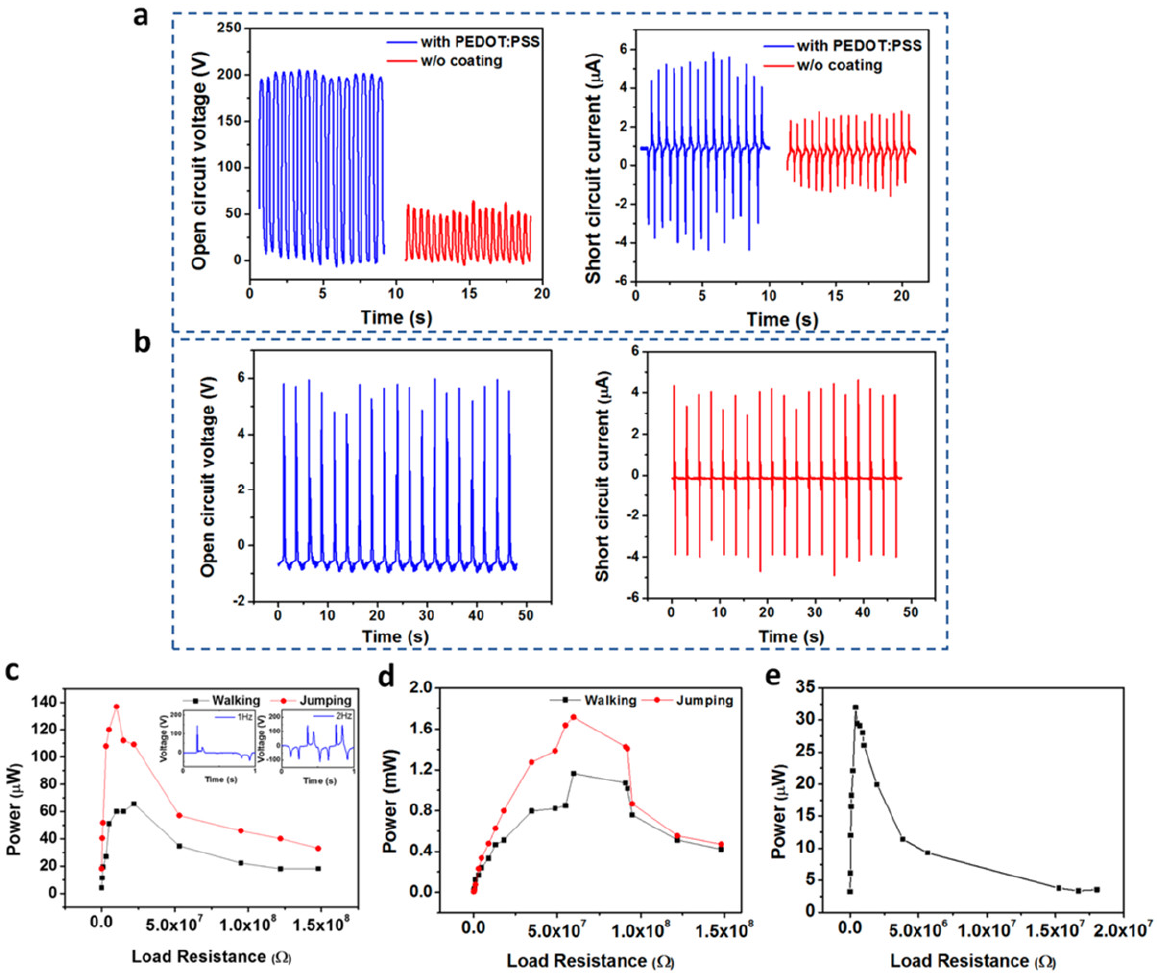
Figure 9. Output electrical performance of the TENG and piezoelectric device integrated in a S 2 -sock designed by Zhu et al. [105]. ( a ) Results of open-circuit voltage and short circuit current of